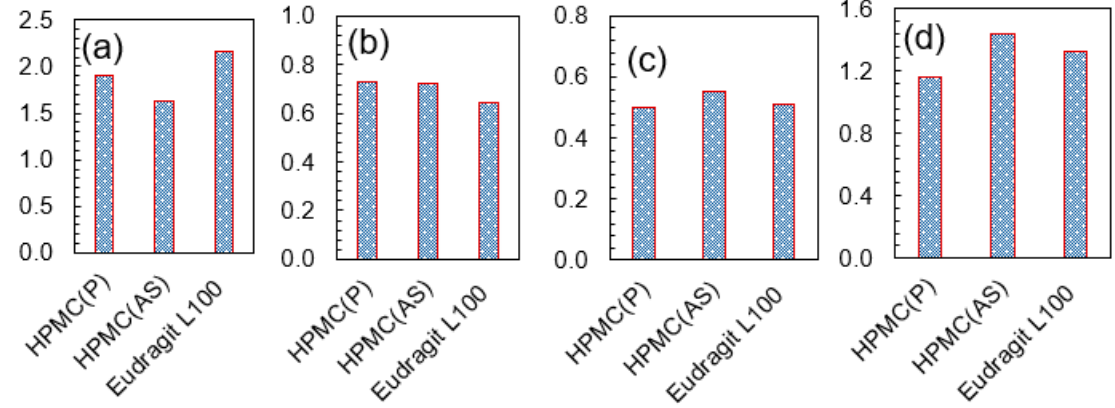
Figure 6. The energy ratios ( a ) NPX–polymer/NPX–NPX, ( b ) NaDLO–polymer/NaDLO–NaDLO, ( c ) DMF–polymer/DMF–DMF, and ( d ) OPZ–polymer/OPZ–OPZ.